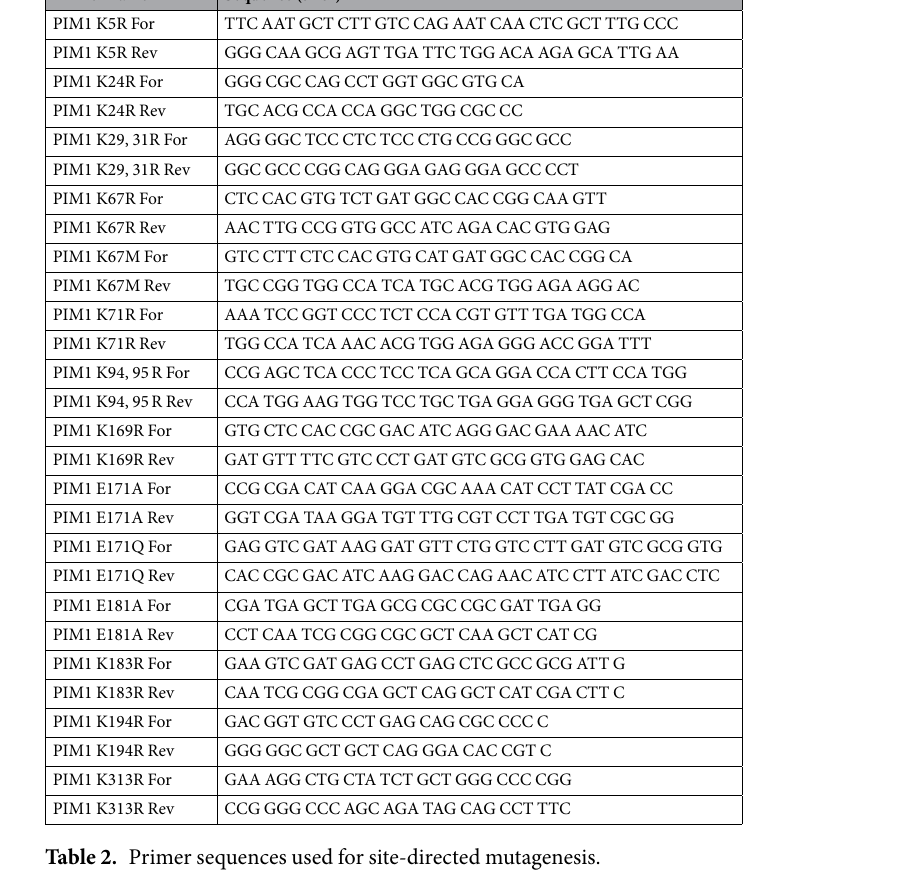
Table 2. Primer sequences used for site-directed